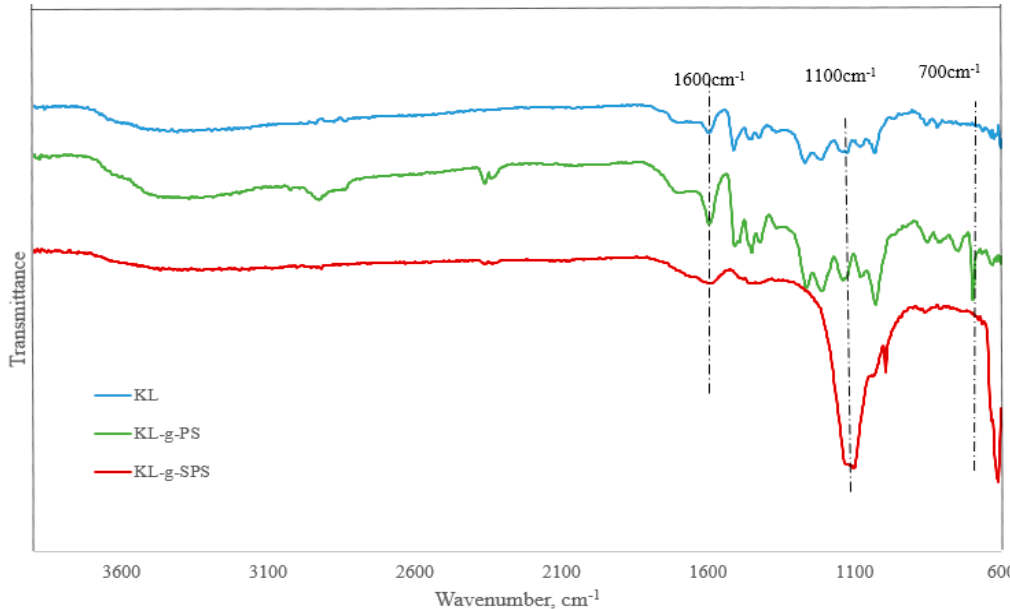
Figure 5. Fourier-transform infrared (FT-IR) spectra of KL, KL- g -PS, and KL- g -SPS polymers.